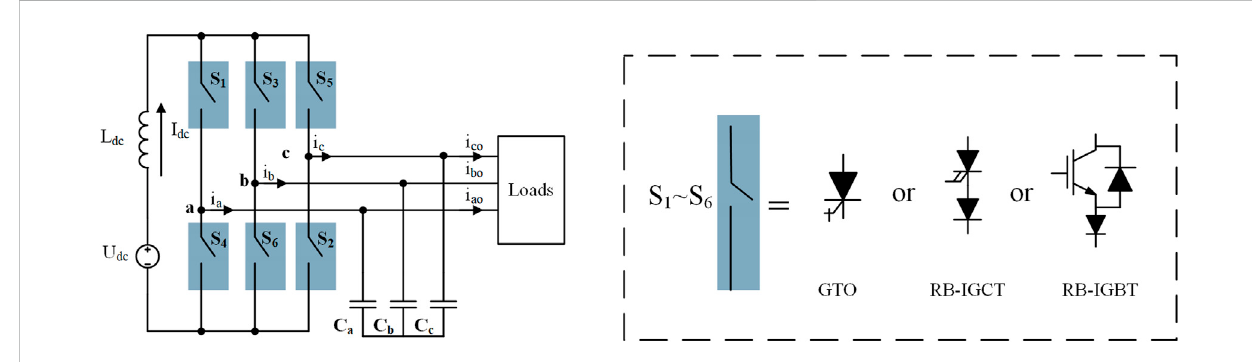
Conventional H6-CSI topology and hardware con fi